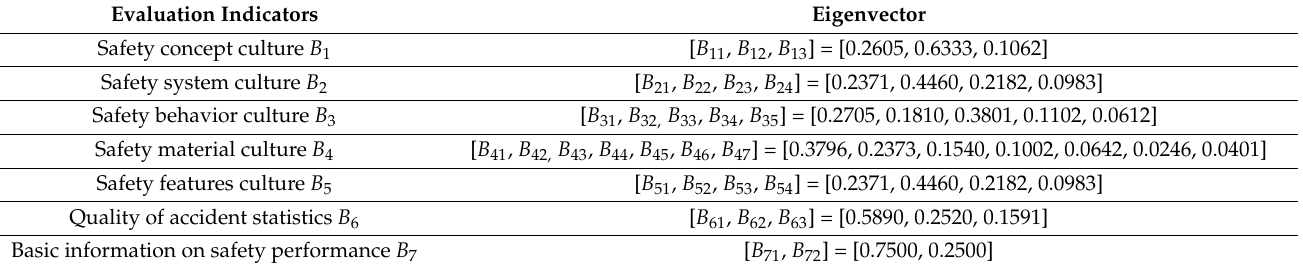
Table 2. Summary table of characteristic vectors of safety culture evaluation